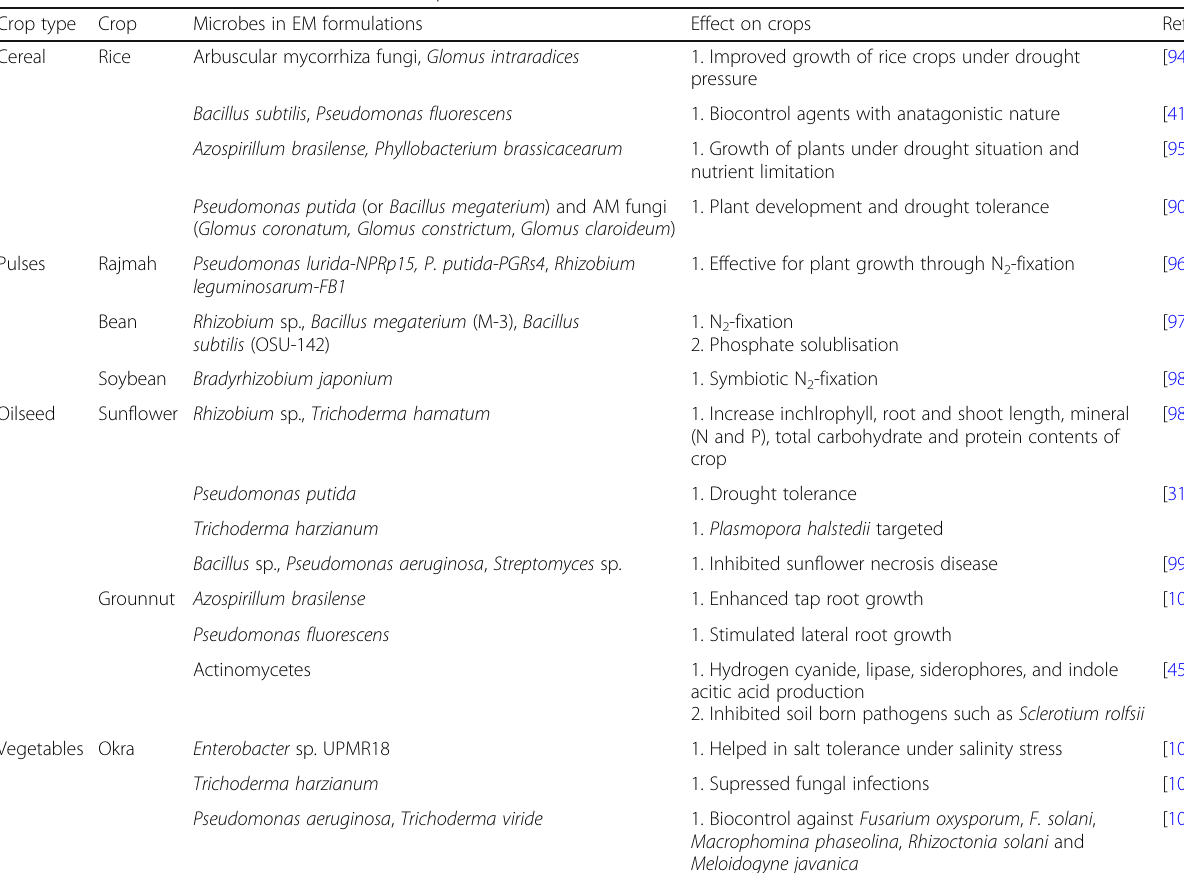
Table 6 EM formulations and their effect on crops Crop type